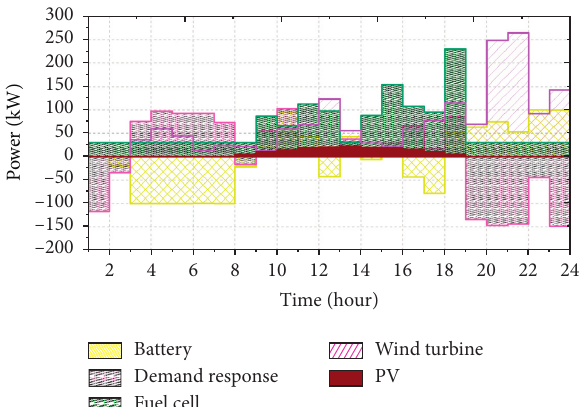
Figure 18: The value of produced power of each energy source on 25th September.